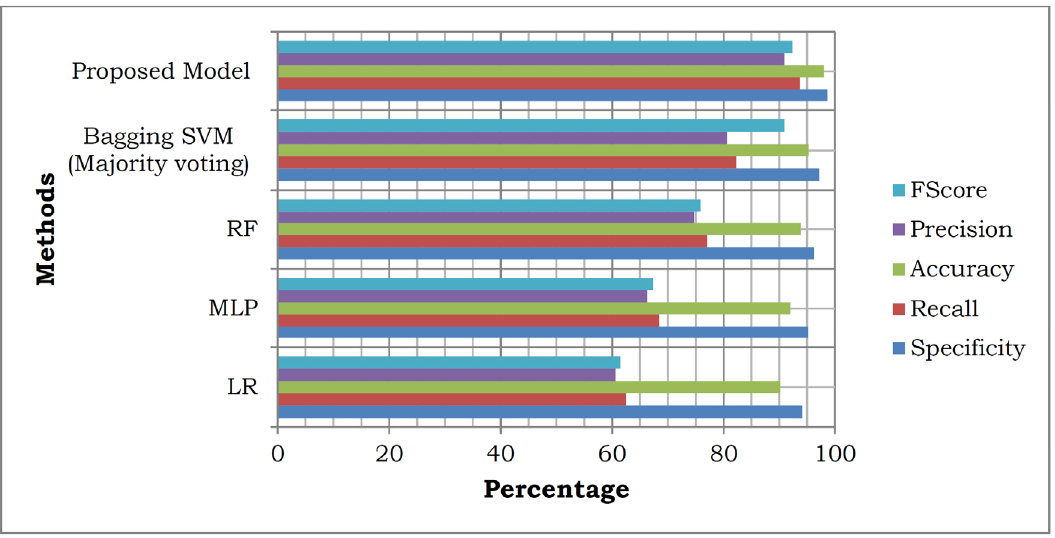
Figure 4. Comparison of evaluation metrics of the proposed model with other approaches.